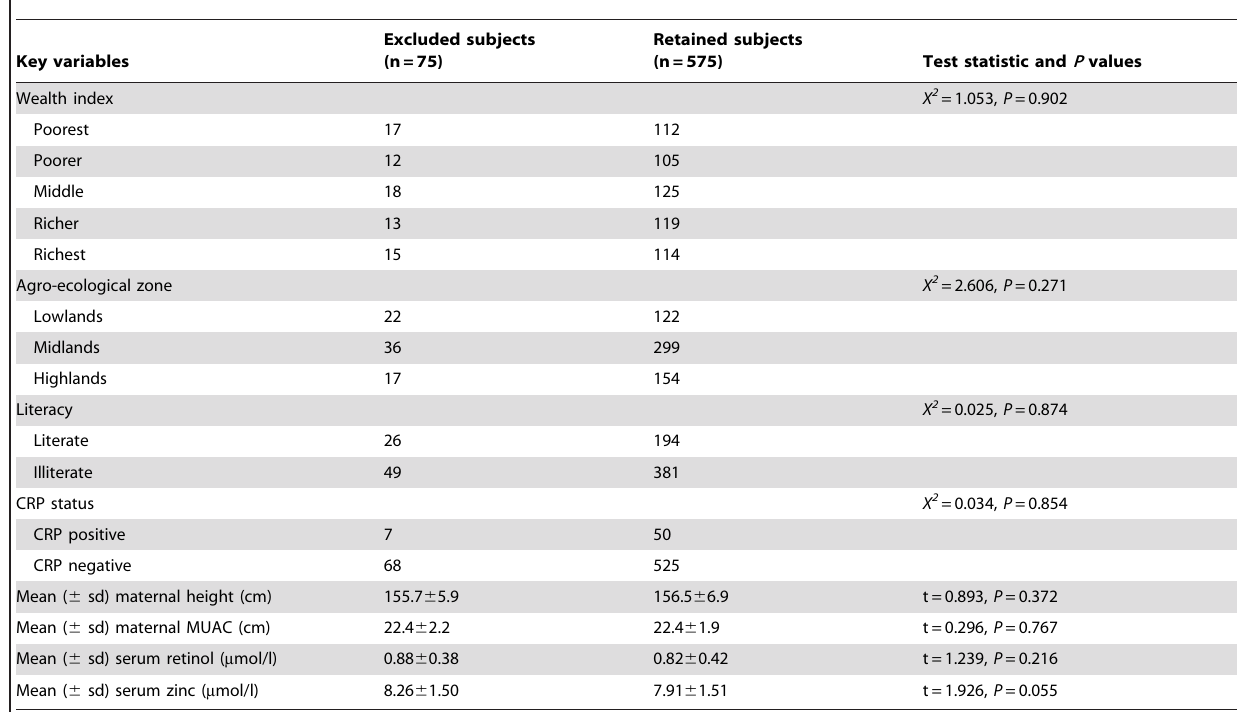
Table 1. Comparability of retained and excluded subjects based on key socio-demographic and nutritional factors.